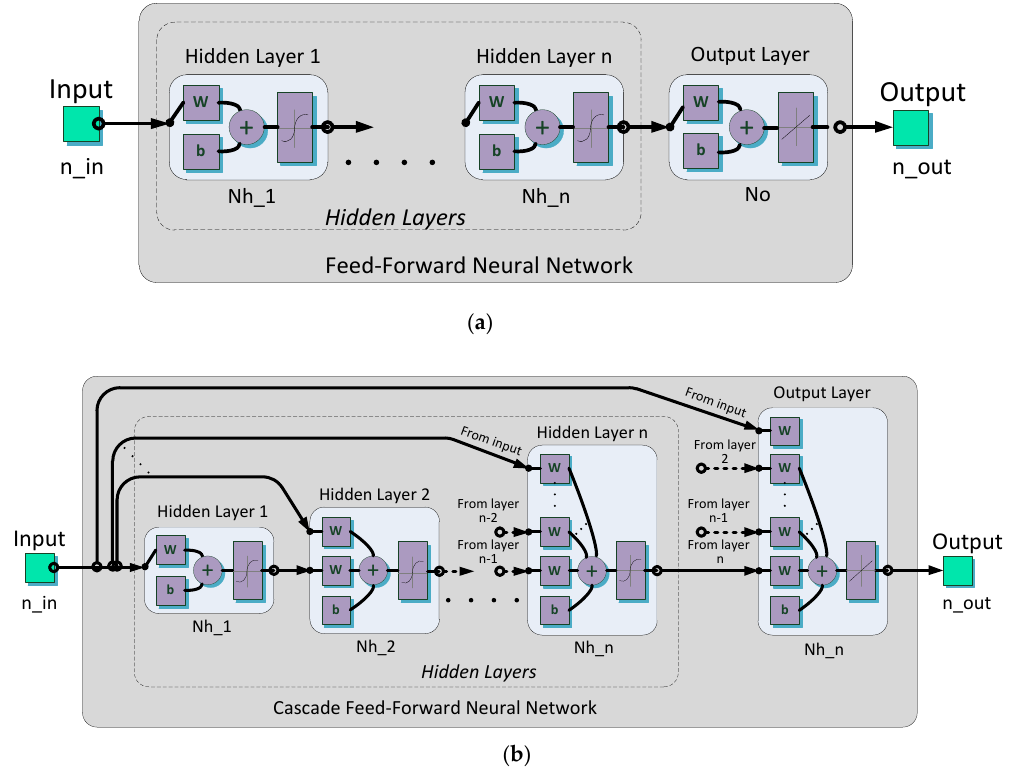
Figure 2. Proposed artificial neural networks (ANN) architectures: ( a ) feed forward and ( b ) cascade feed forward classes.